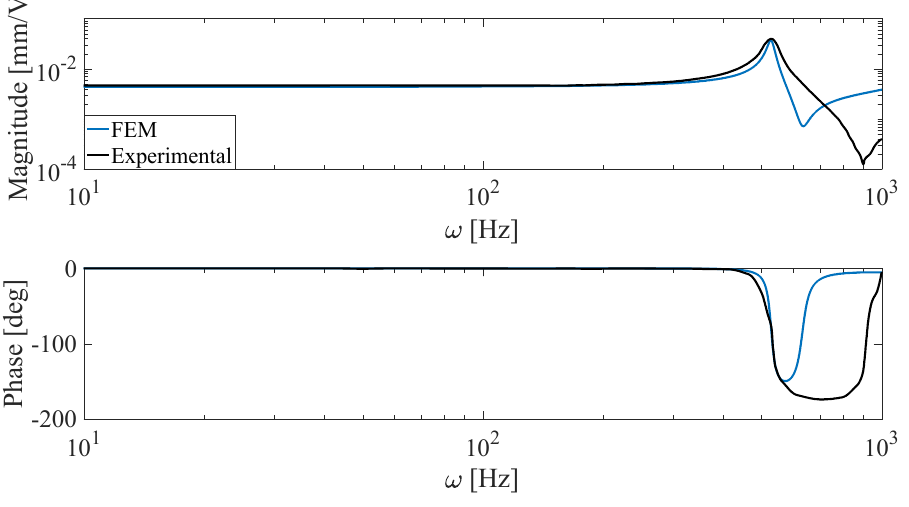
Figure 11. Comparison between FEM and experimental frequency response.